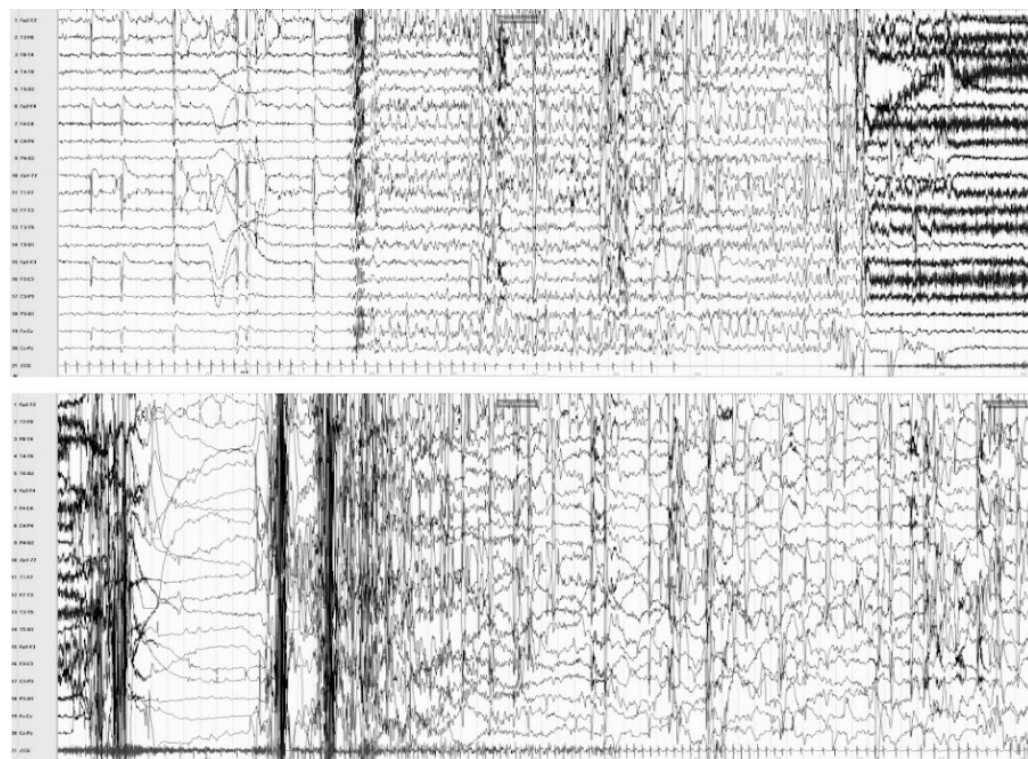
Figure 1. Subject #6, simultaneous video-EEG/EKG recording: ictal asystole during a focal seizure arising from the right frontal lobe. The EEG shows a rhythmical spike-and-wave discharge over right fronto-temporal regions and vertex, subsequently spreading to the homologous contralateral regions. The EKG documents a seizure-related change in cardiac activity, consisting of bradycardia, starting 8 s after seizure onset and evolving in asystole (duration: 20 s).